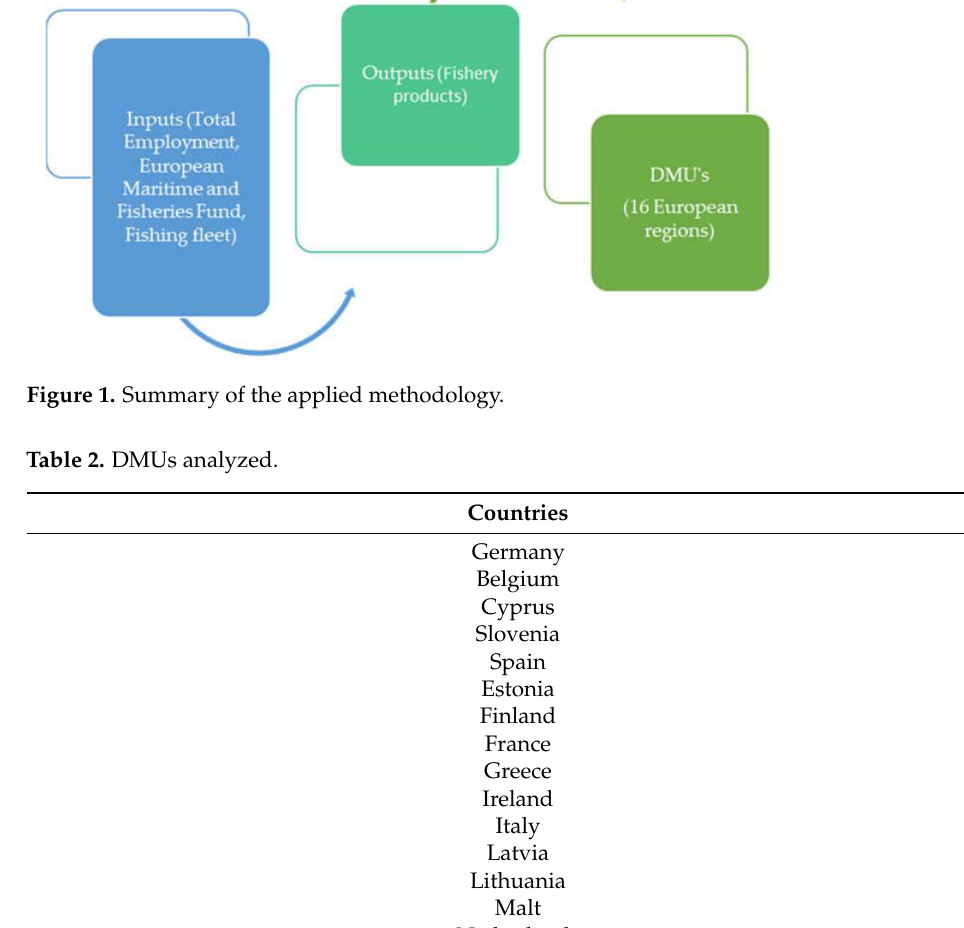
Table 2. DMUs analyzed.